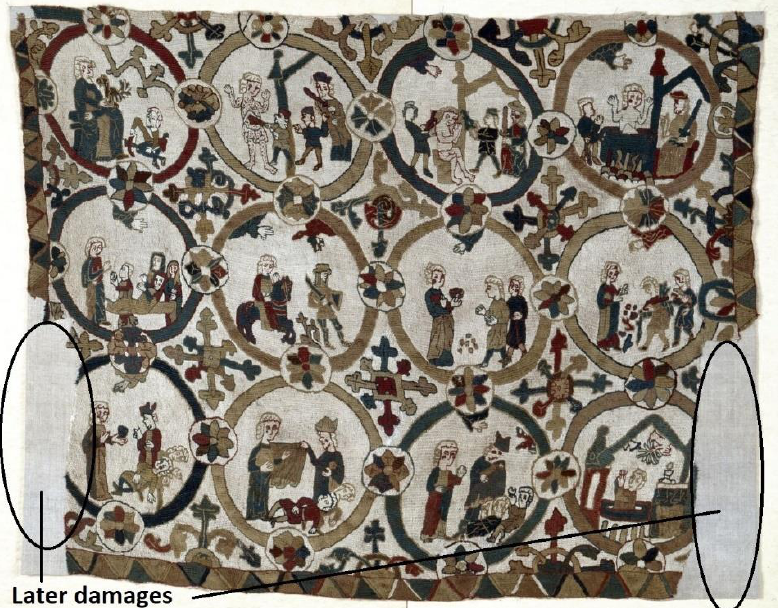
Figure 1. The Svalbarð cloth as it is today. The missing edges to the left and the right show damage that occurred long after it was in use (© National Museum of Iceland).